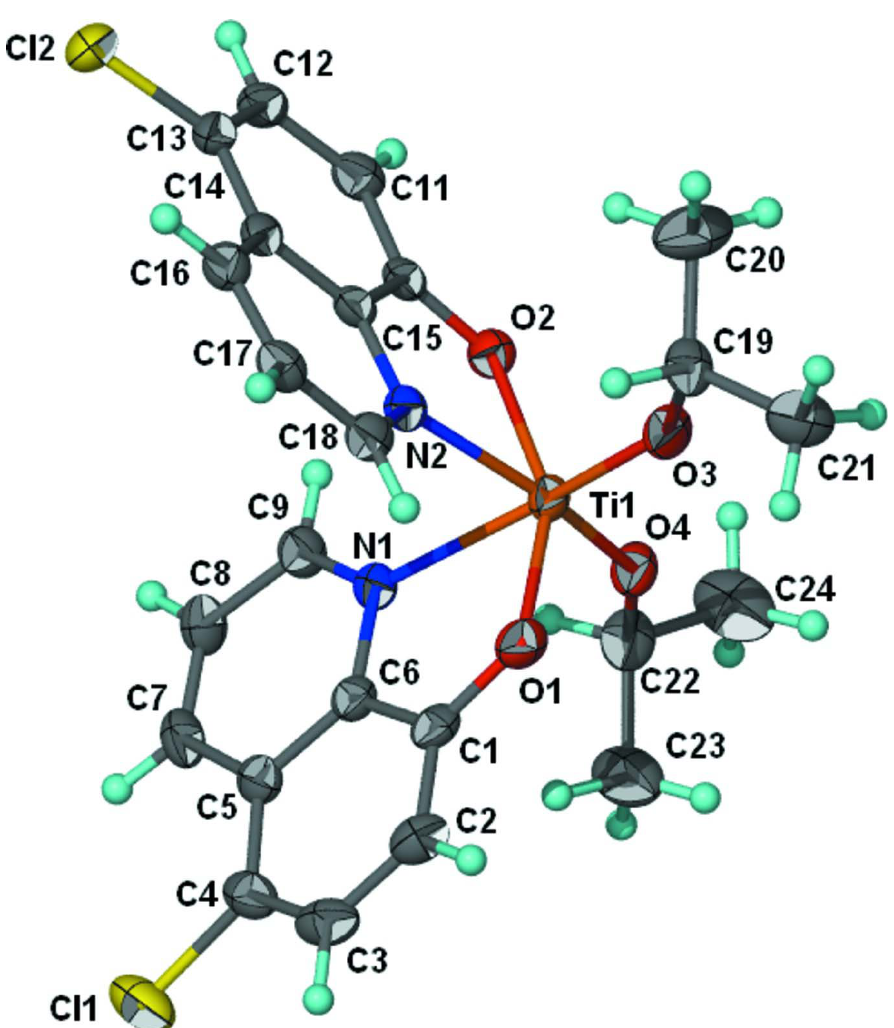
H O) (C H ClNO) (C H O) ; ellipsoids are drawn at the 3 7 2 9 5 2 3 7 2